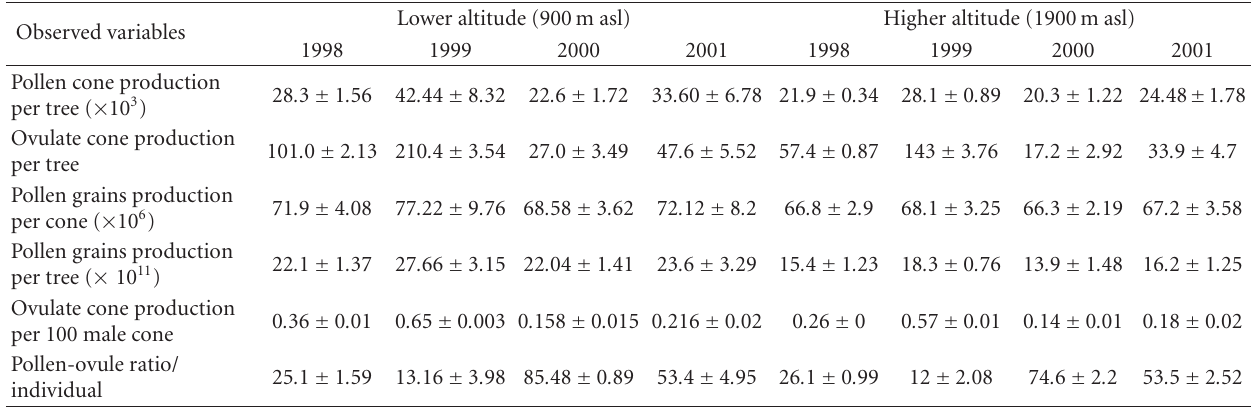
Table 3: Production potential of reproductive organs in P. roxburghii.